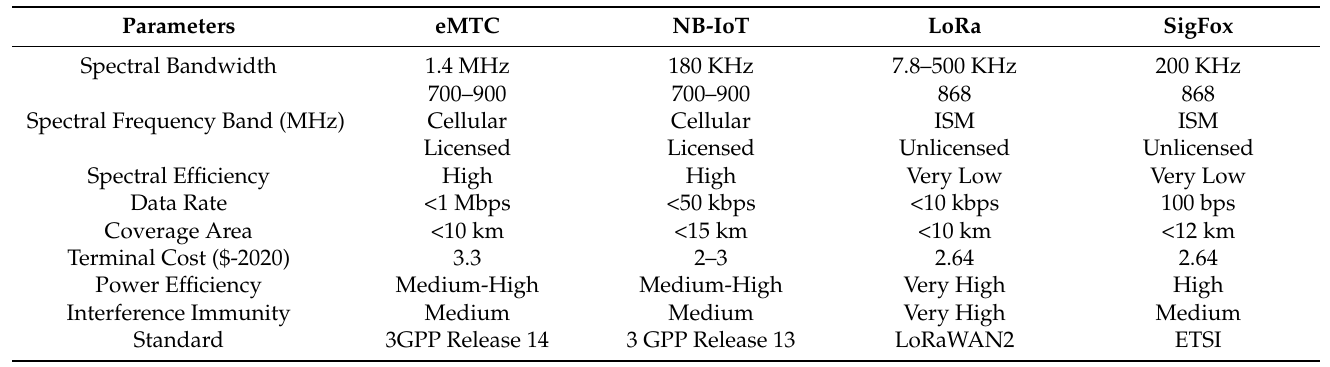
Table 5. Comparison between NB-IoT frequency band and other